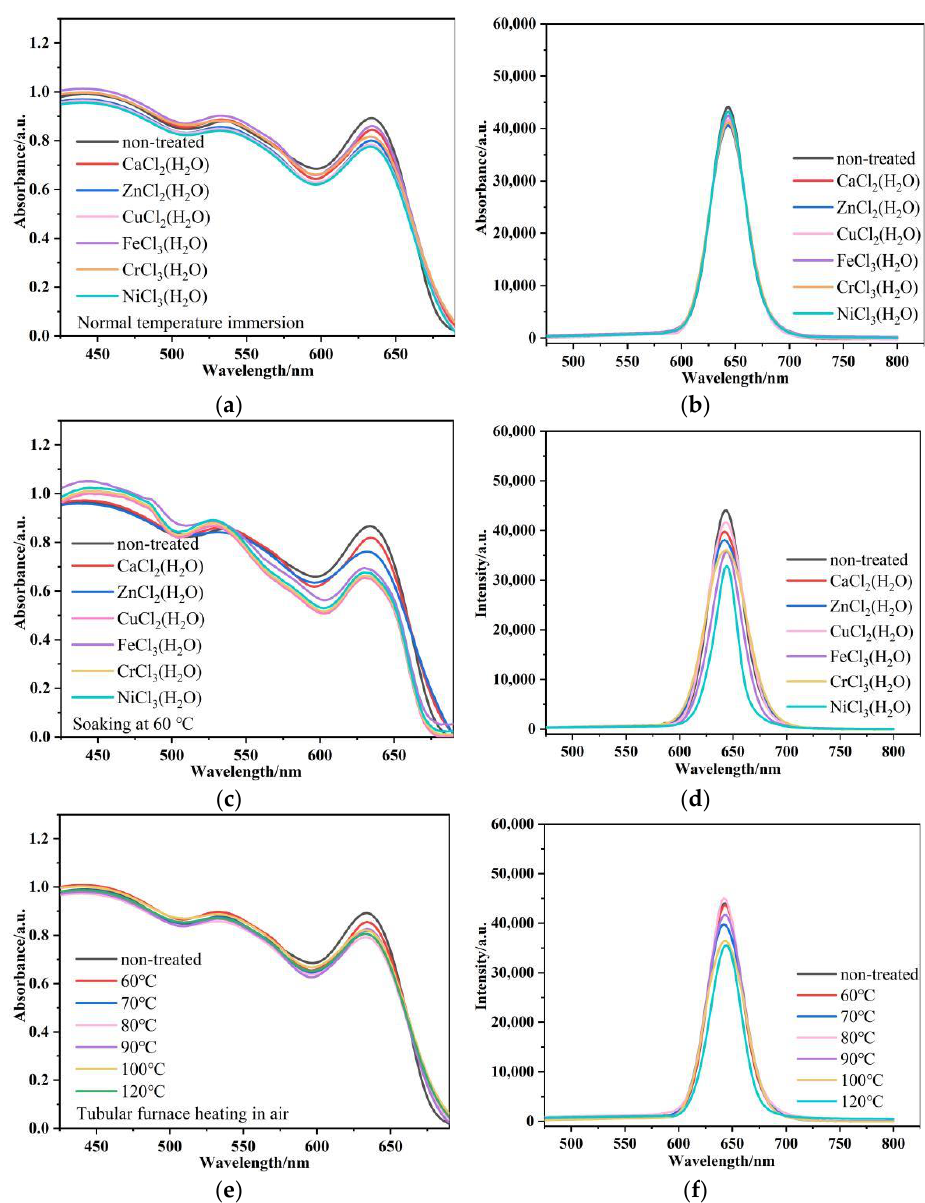
Figure 7. Absorption ( a , c , e ) and PL ( b , d , f ) spectra of CdSe@P(S+MMA) hybrid fibers under different conditions: ( a , b ) 30 min after the dropping of room temperature; ( g , h ) after 30 min with aqueous solutions of different metal salts; ( e , f ) after 30 min of dry heating at different temperatures. λ exc = 450 nm.